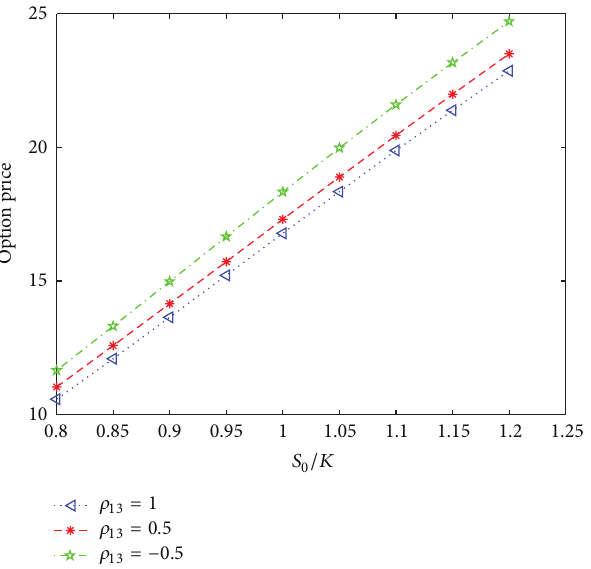
Figure 6: The option price in Markov-modulated model and non- Markov-modulated